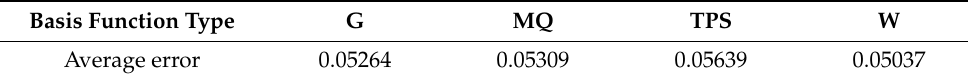
Figure 3. Semicircle expansion. Table 4. Comparison of the basis functions in terms of the interpolation